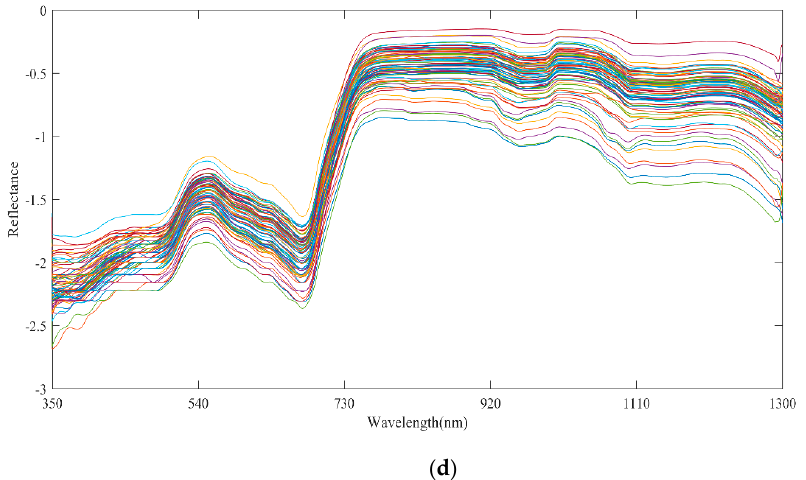
Figure 3. Spectral reflectance of rice canopy in all plots at the whole fertility period. ( a ) Original canopy spectral reflectance; ( b ) first − derivative canopy spectral reflectance; ( c ) reciprocal spectral reflectance; ( d ) logarithmic spectral reflectance.